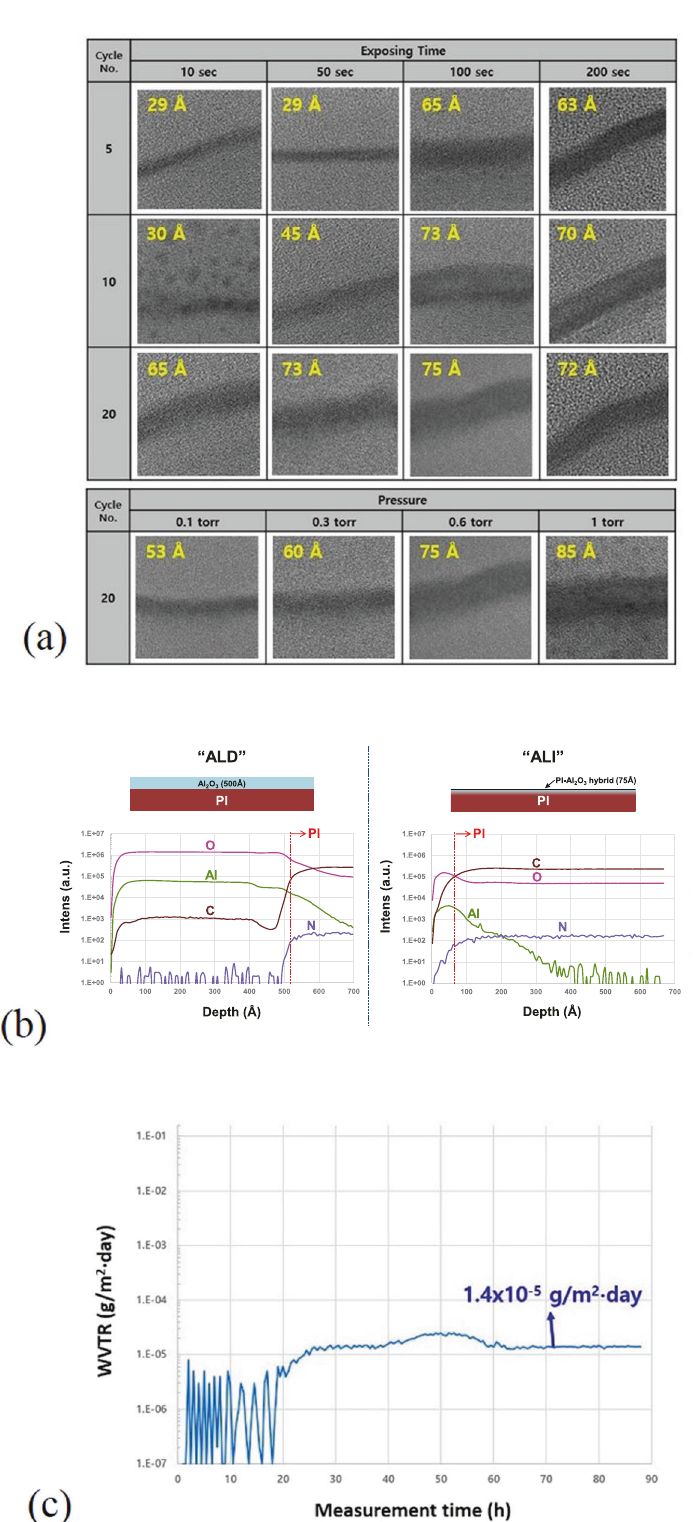
Fig. 2 The results of TEM, SIMS and WVTR. a TEM results according to process conditions. b SIMS results for the ALD and ALI processes. c WVTR measurement results for the PI-Al 2 O 3 hybrid the total amount of out-gassing was 14,653,472 arbitrary units (A.U.). Conversely, in the PI-Al 2 O 3 hybrid nanolayer case under the same conditions, only a small amount of acetaldehyde and acetone were discharged to the environment and the total